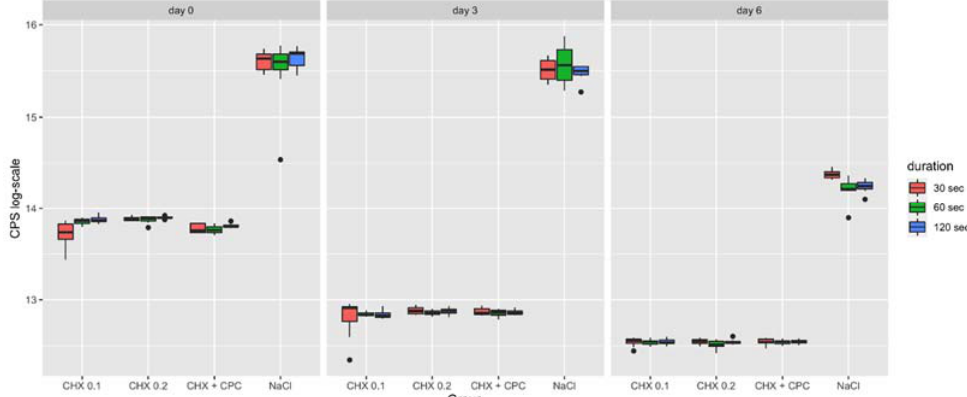
Figure 1. Boxplot representing the cell viability of SaOS-2 cells following the different treatment procedures (i.e., CHX 0.1, CHX 0.2, CHX + CPC and NaCl for 30, 60 and 120 s) at day 0, 3 and 6. Data are expressed in counts per second (CPS). Table 1. Cell viability. A multiple Kruskal − Wallis test was performed to compare the groups at each time point (i.e., at day 0, 3 and 6), and in the case of significance, a post hoc multiple compari- son test with Bonferroni p -value adjustment was performed. The adjusted p -values from post hoc test are reported and labeled as follows: * p < 0.05, ** p < 0.01, *** p < 0.001.